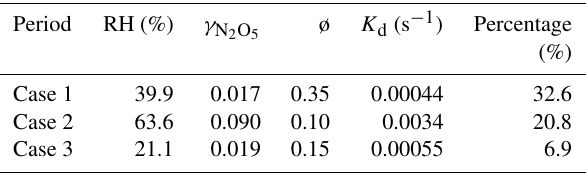
Table 2. Estimated uptake coefficient of N 2 O 5 , ClNO 2 produc- tion yield, and related parameters for the selected periods on three